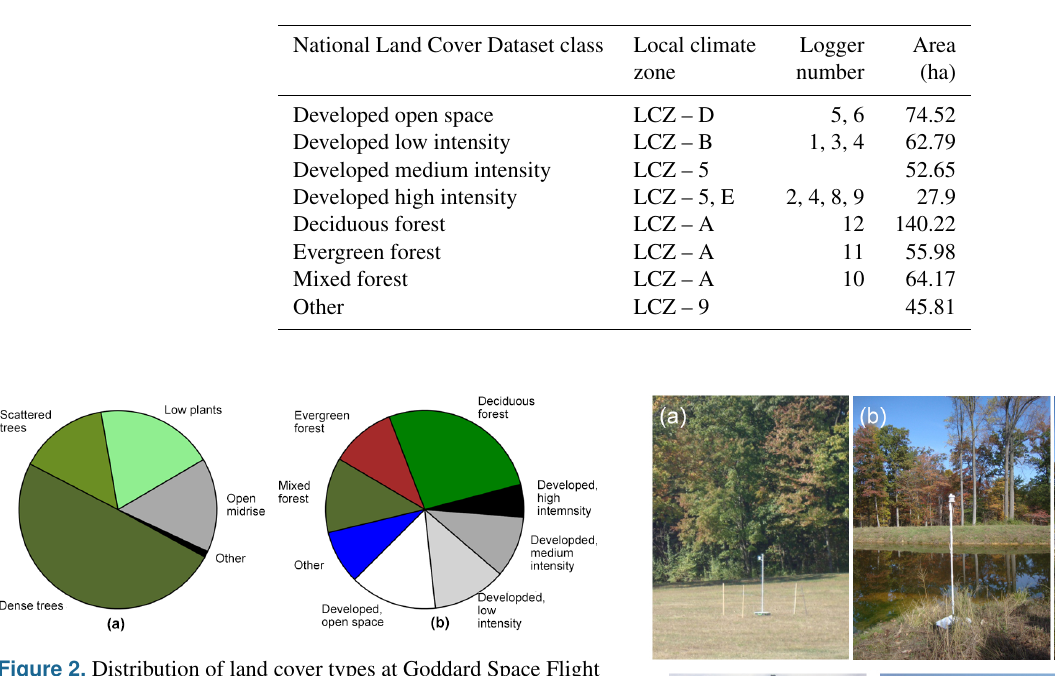
Table 2. Total area of each land cover type for GSFC as determined by the NLCD and related to the local climate zone (LCZ) of Stewart and Oke (2012).